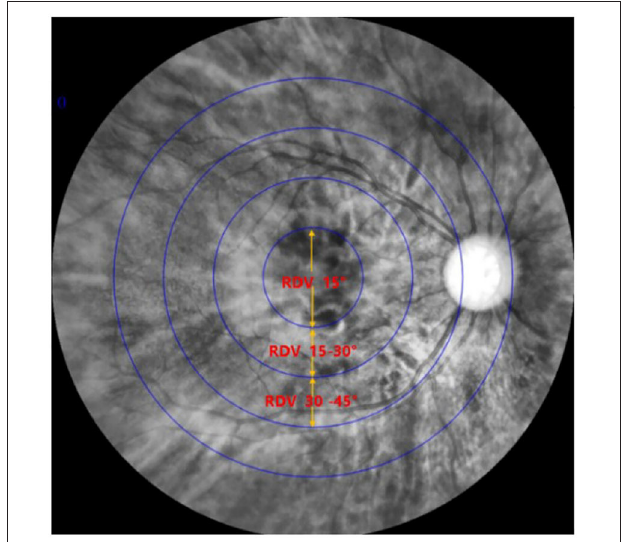
FIGURE 3 | Sketch map of ranges to measure peripheral refraction (RDV-15, RDV 15–30, and RDV 30–45).